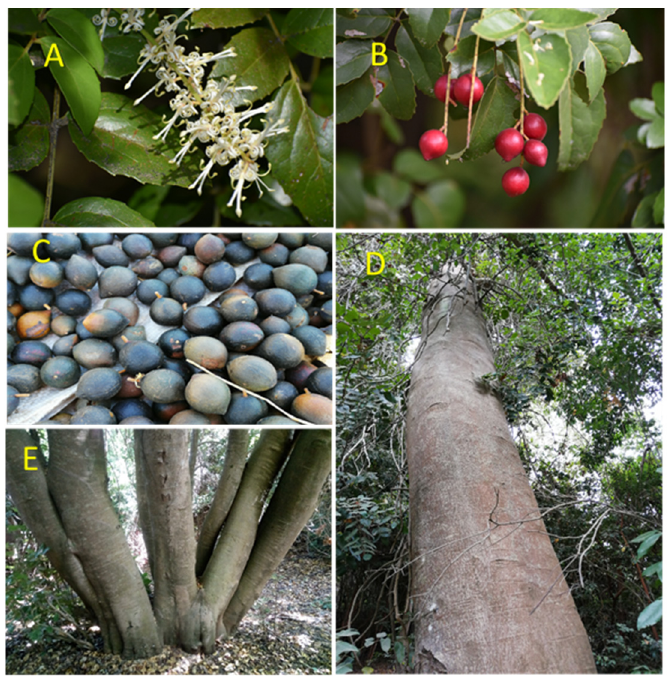
Figure 1. Gevuina avellana Mol. ( A ) Inflorescence. ( B ) Immature fruits. ( C ) Ripe fruits. ( D ) Straight trunk. ( E ) Branched trunk.